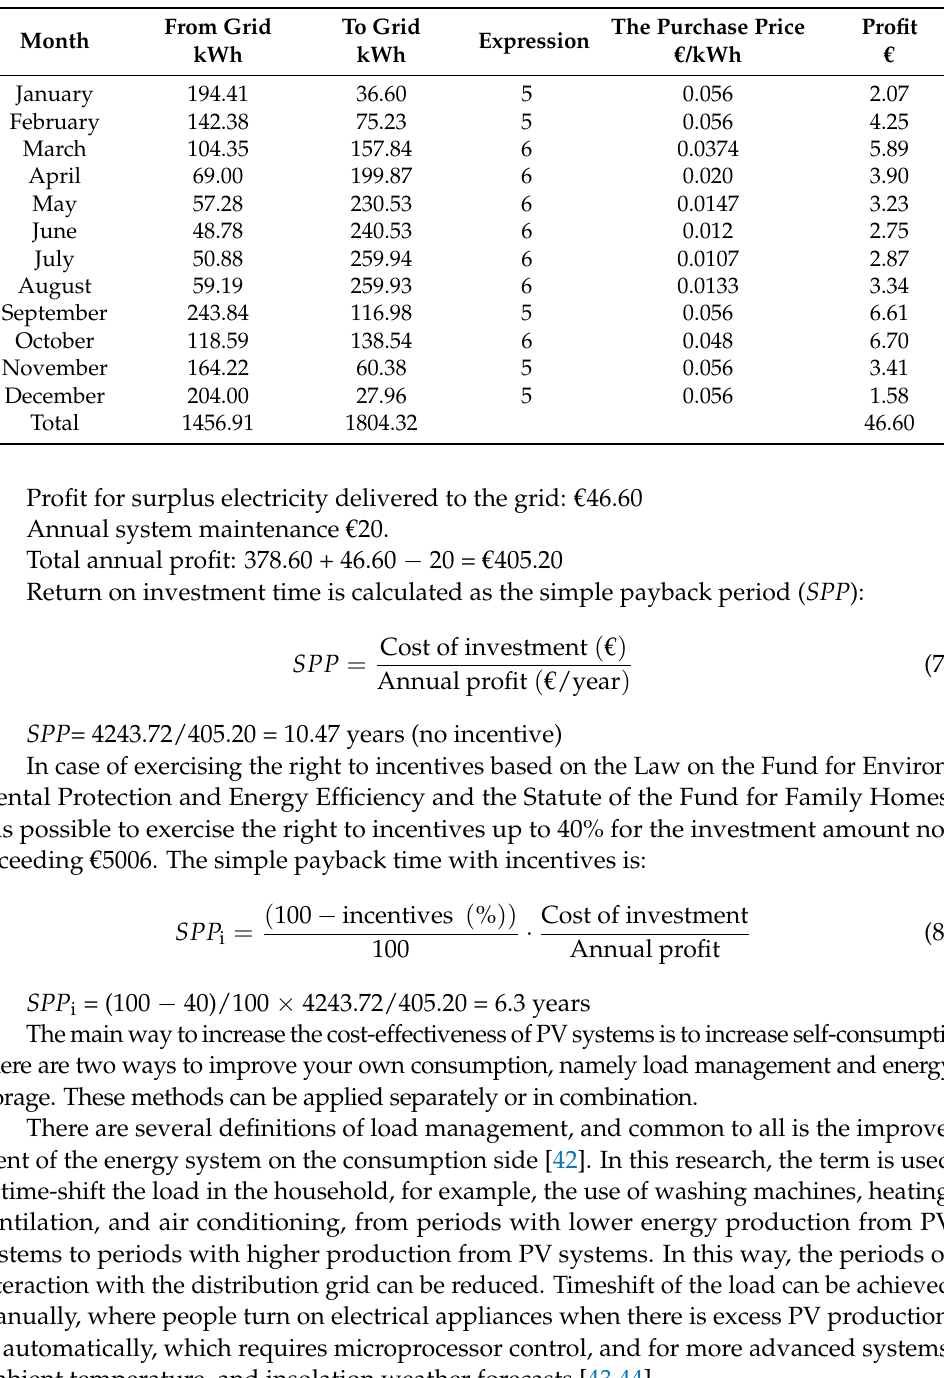
Table 10. Calculation of profit for sold surplus